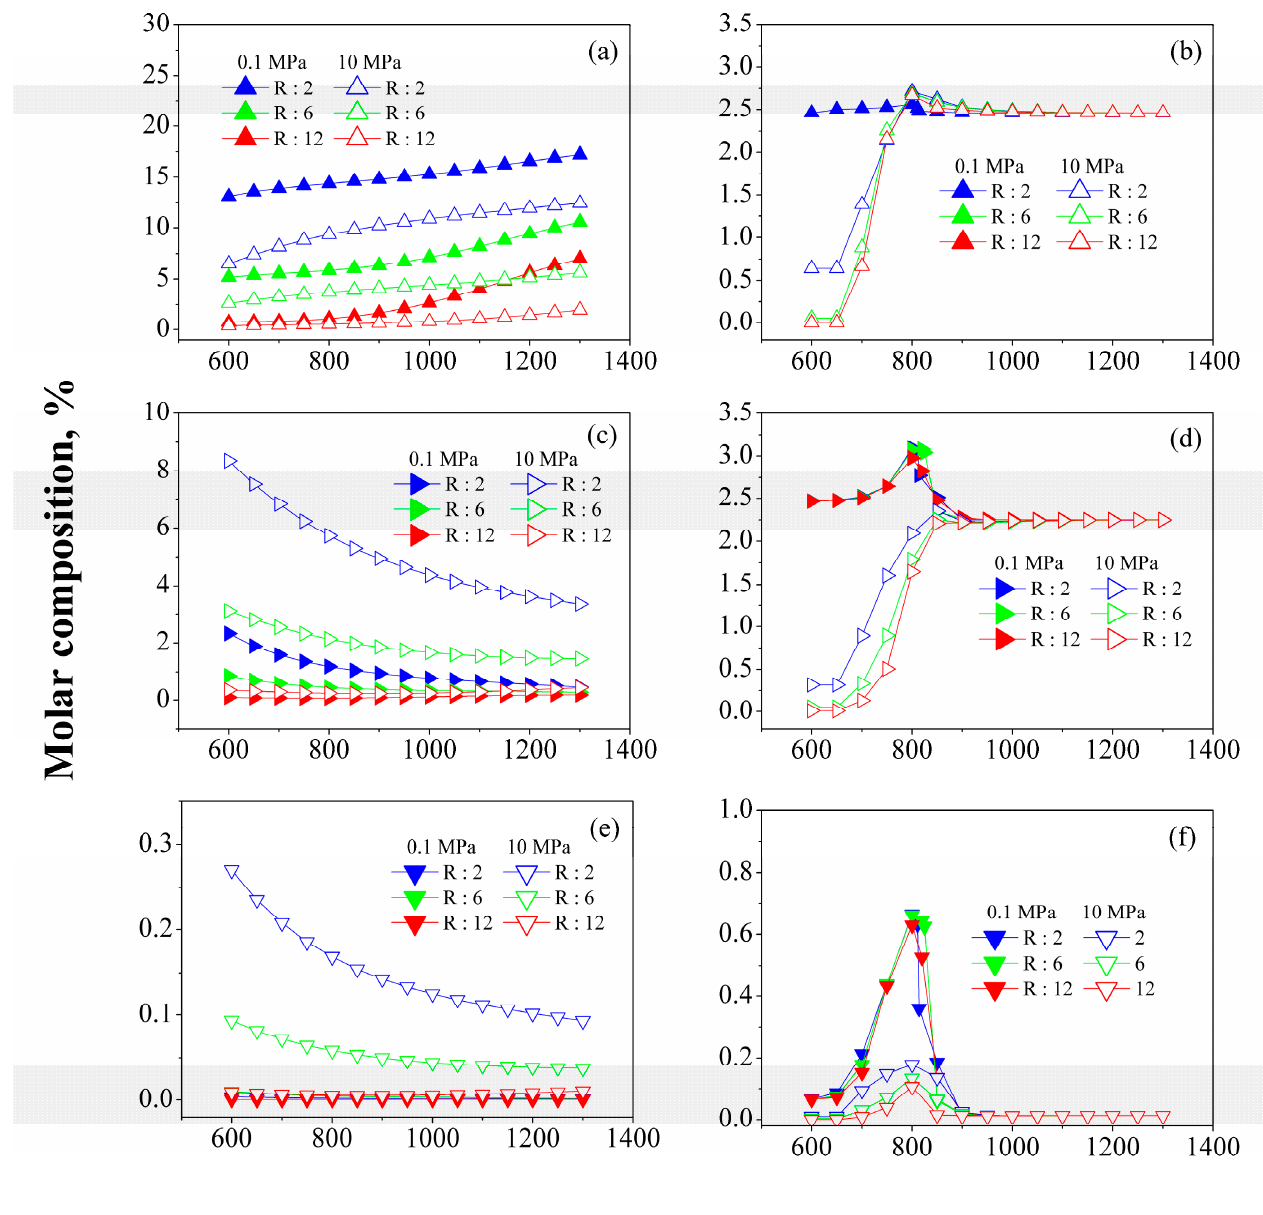
Figure 8. Effect of H 2 /HC ratio on aromatics distribution: ( a ), ( c ), ( e ) Equilibrium. ( b ), ( d ), ( f ) Cata- lytic. (